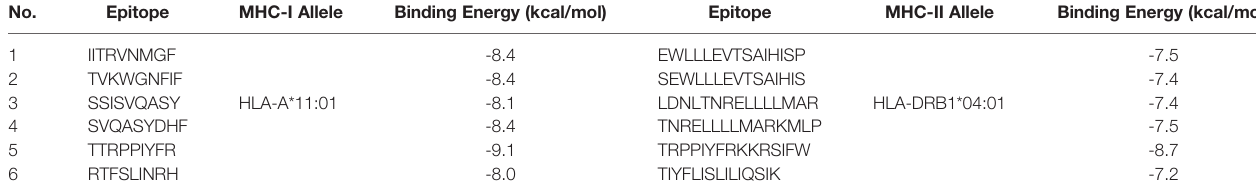
TABLE 4 | The binding energy of T cell epitopes with their respective allele.